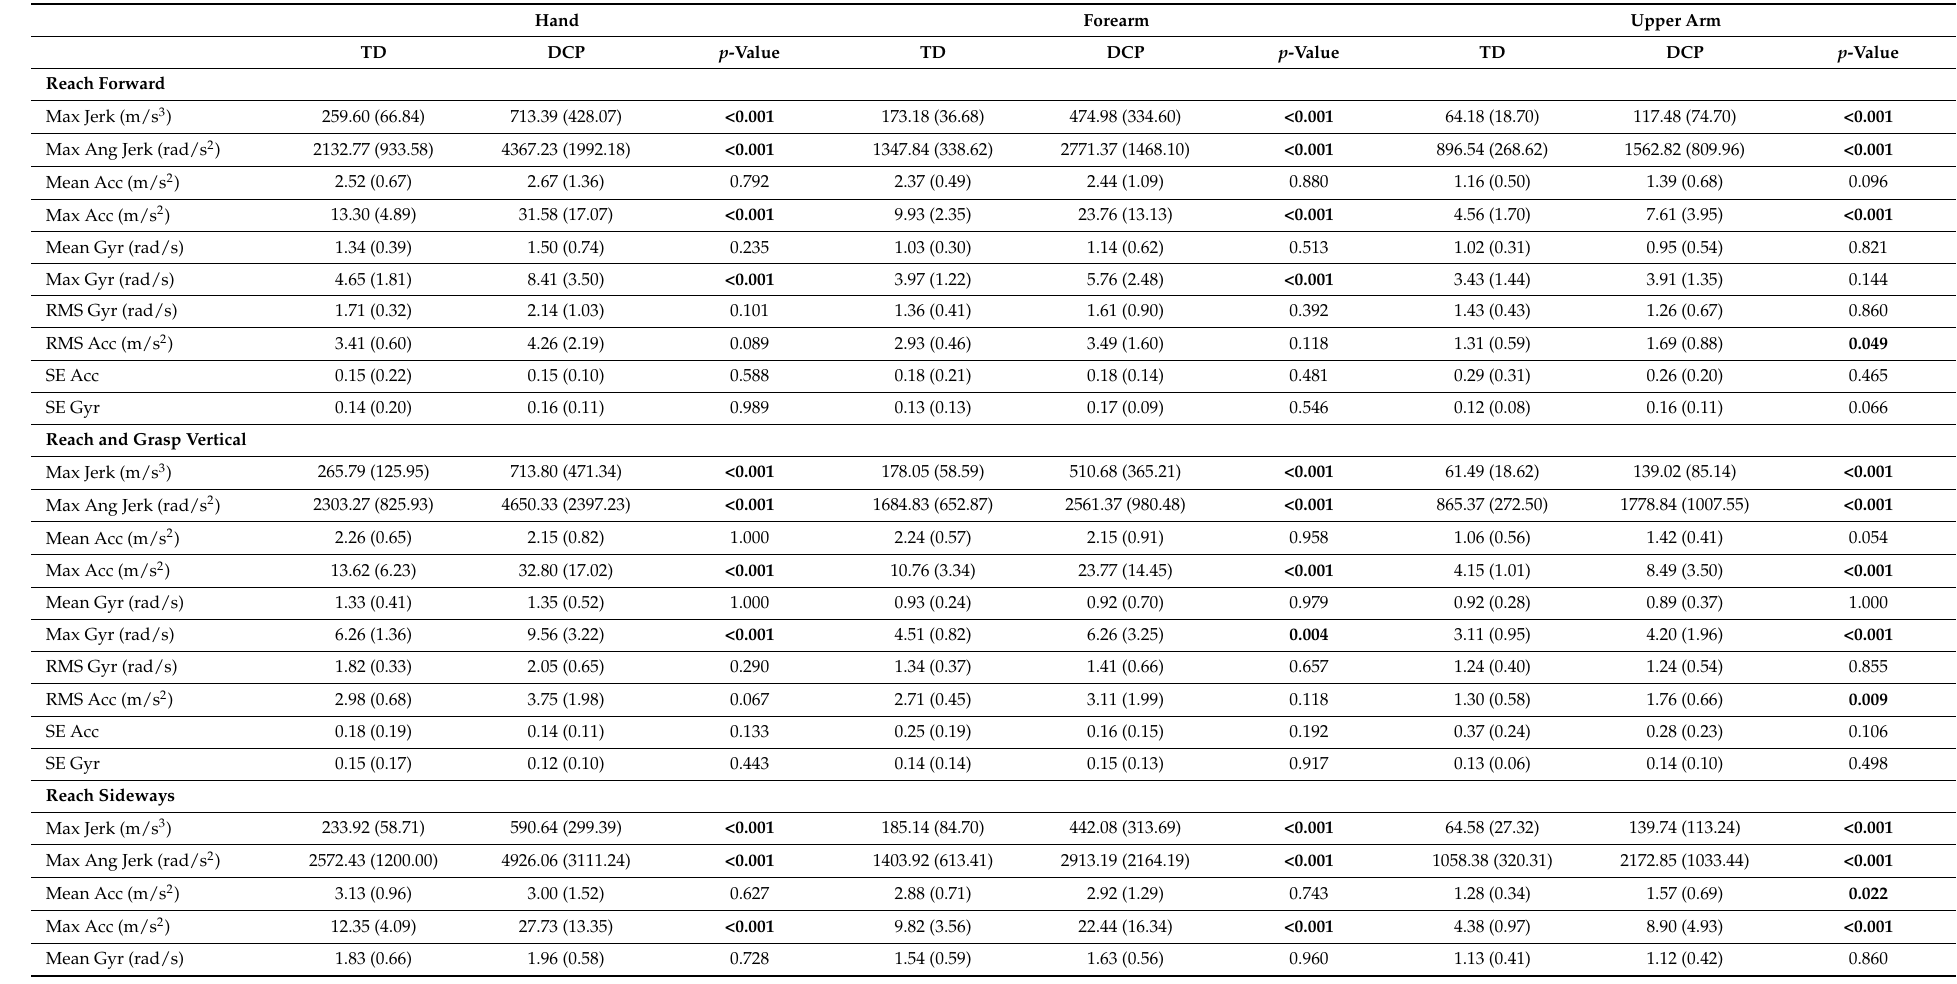
Table 1. Median and interquartile ranges for sensor parameters as well as p -values for between-group differences. TD = typically developing; DCP =